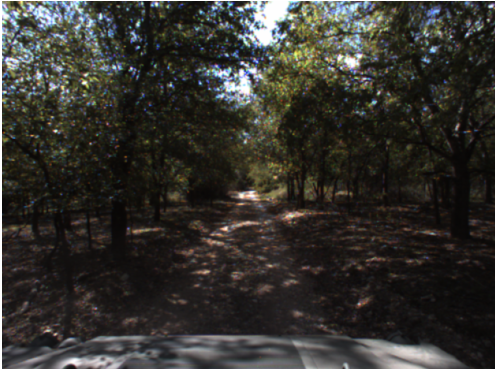
Figure 2. A section of the trail, illustrating overhanging foliage and grass.